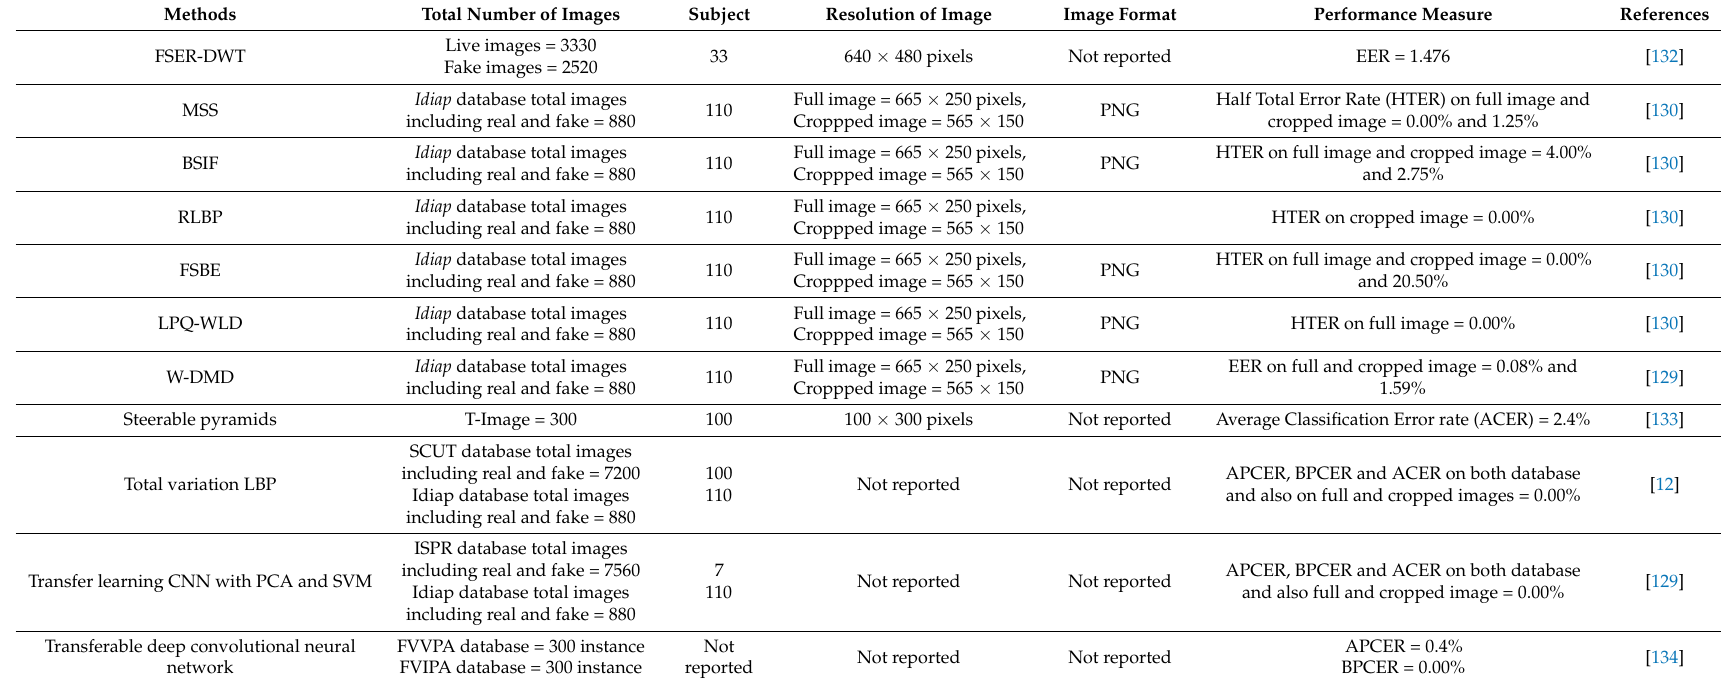
Table 8. Existing spoofing attack